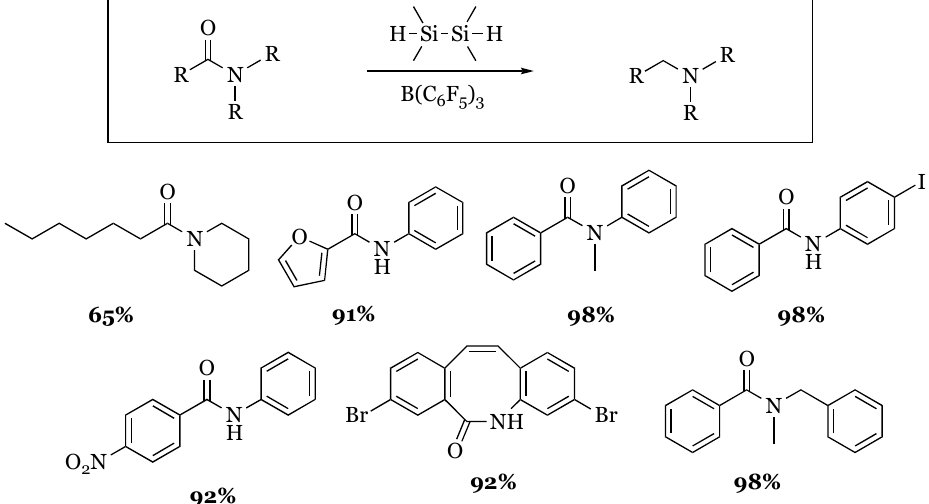
Figure 25. Tetramethyldisilane reduction of select amides with tris(pentafluorophenyl)borane.